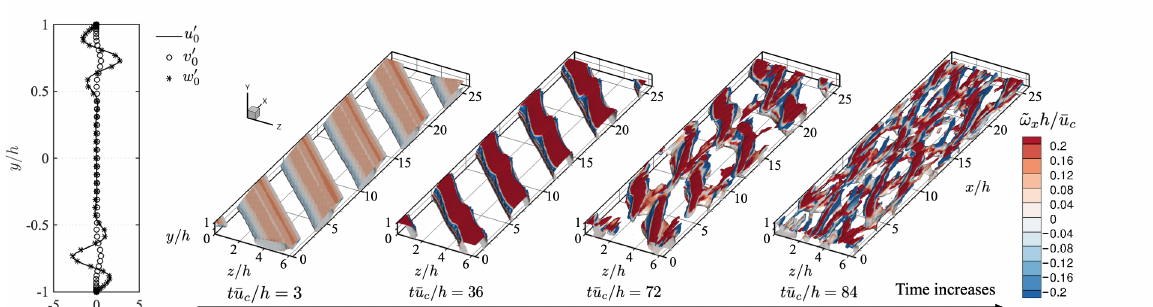
Figure 3. Time evolution of flow field to illustrate the laminar-to-turbulent transition process for the case ( α , β ) = ( 1,1 ) : The flow is initialized by optimal disturbance with kinetic energy density of ( h / ¯ u c ) 2 = 0.001) colored by streamwise vorticity E 0 = 0.5 10 − 4 . Iso-surfaces of -criterion [35] ( × Q Q ˜ ω x h / ¯ u c are visualized. Only the upper half domain ( y 0) is displayed for clarity. ≥